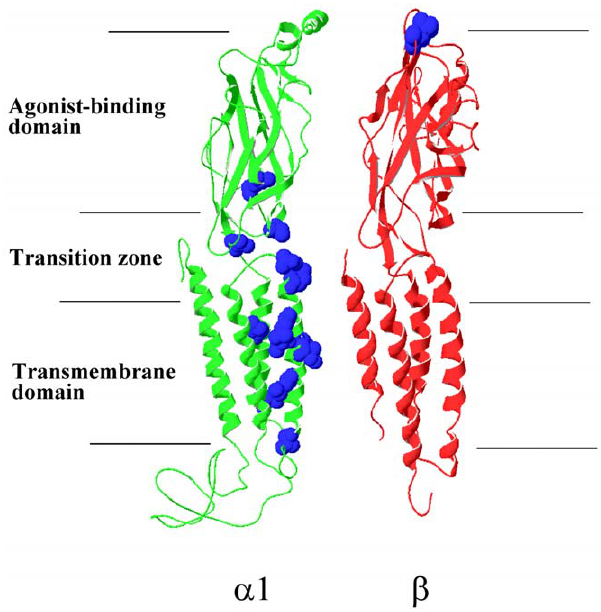
Figure 1. Distribution of hereditary hyperekplexia-causing mutations in the GlyR a 1 and b subunits. The hereditary hyperekplexia-causing mutations that disrupt the GlyR channel function rather than block surface expression, are mapped onto the structure models [3] of GlyR a 1 (A52S, E103K, R218Q, S231N, I244N, P250T, V260M, T265I, Q266H, S267N, R271L/Q, K276E and Y279C) and b (G229D) subunits.